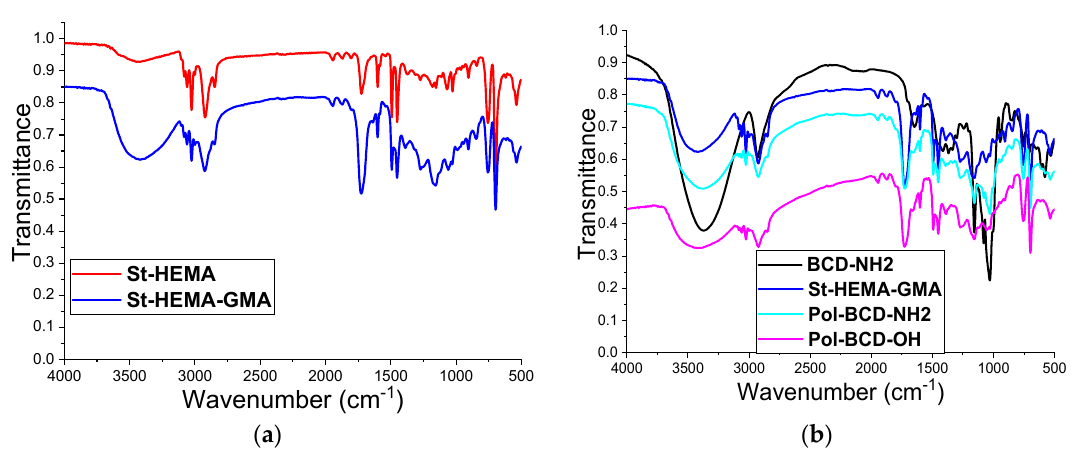
Figure 2. FT-IR spectra for ST-HEMA, BCD-NH 2 , ST-HEMA-GMA-BCD-NH 2 , ST-HEMA-GMA-BCD-OH, ST-HEMA-GMA, ST-HEMA. ( a )ST-HEMA; ST-HEMA-GMA; (b ) BCD-NH2; ST-HEMA-GMA; Pol-BCD-NH2; Pol-BCD-OH